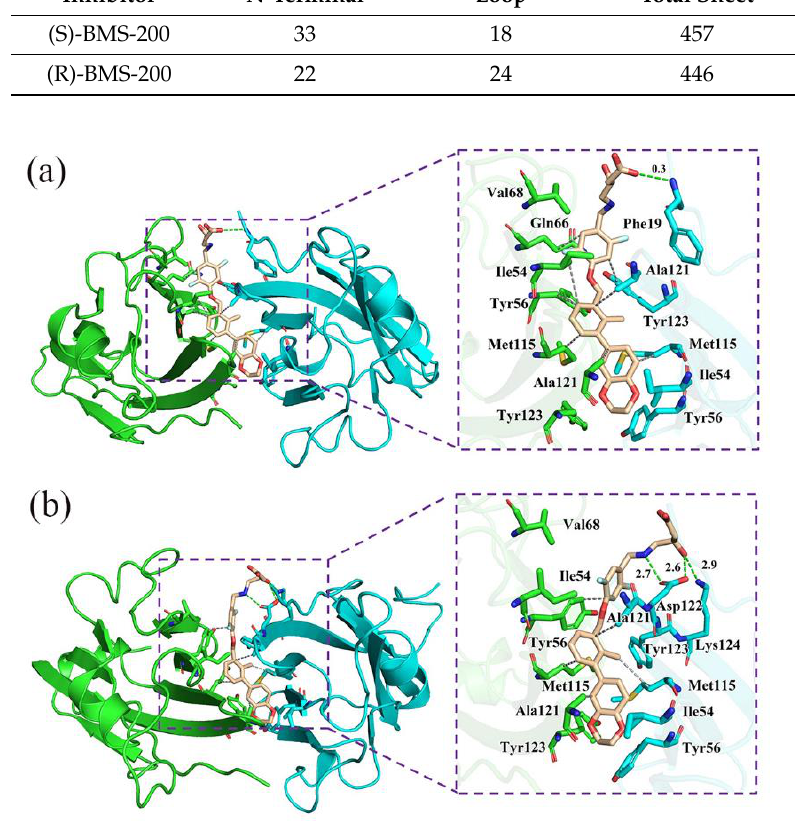
Figure 5. The binding modes of the ( a ) S and ( b ) R systems. The key residues on A PD-L1 and B PD-L1 are shown as cyan and green sticks, respectively, while the ligands are shown as beige sticks. The hydrophobic interactions and H bonds are shown as grey and green dashes,